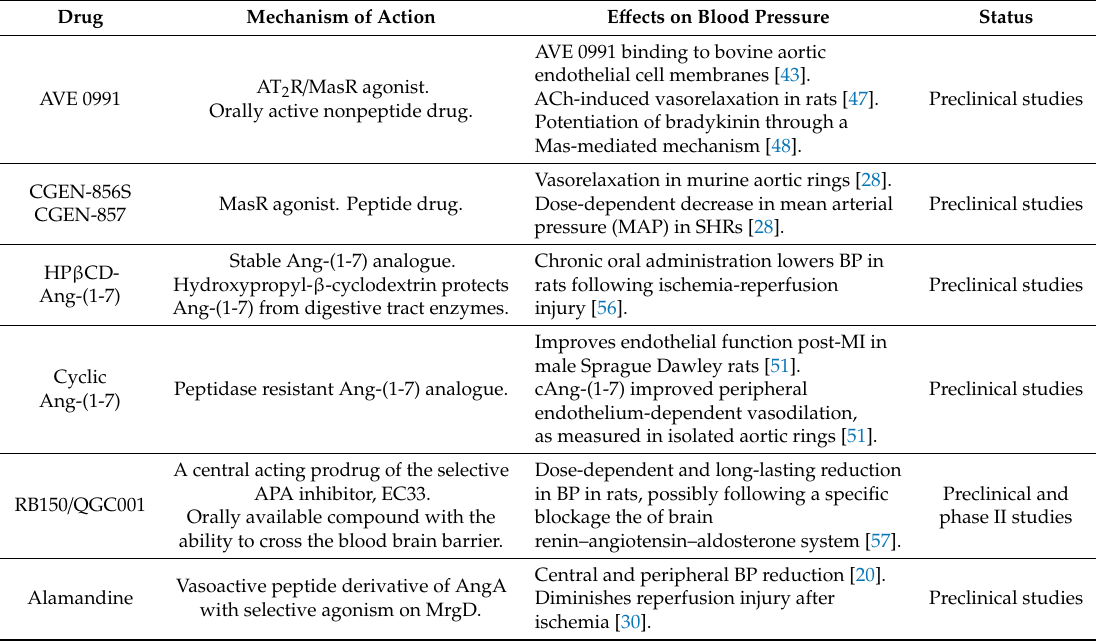
Table 1. Emerging potential drugs interacting with